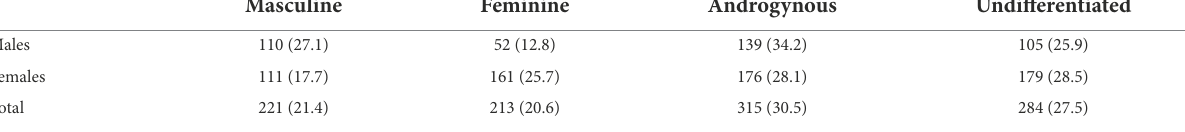
TABLE 2 Gender role distribution (%). Masculine Feminine Androgynous